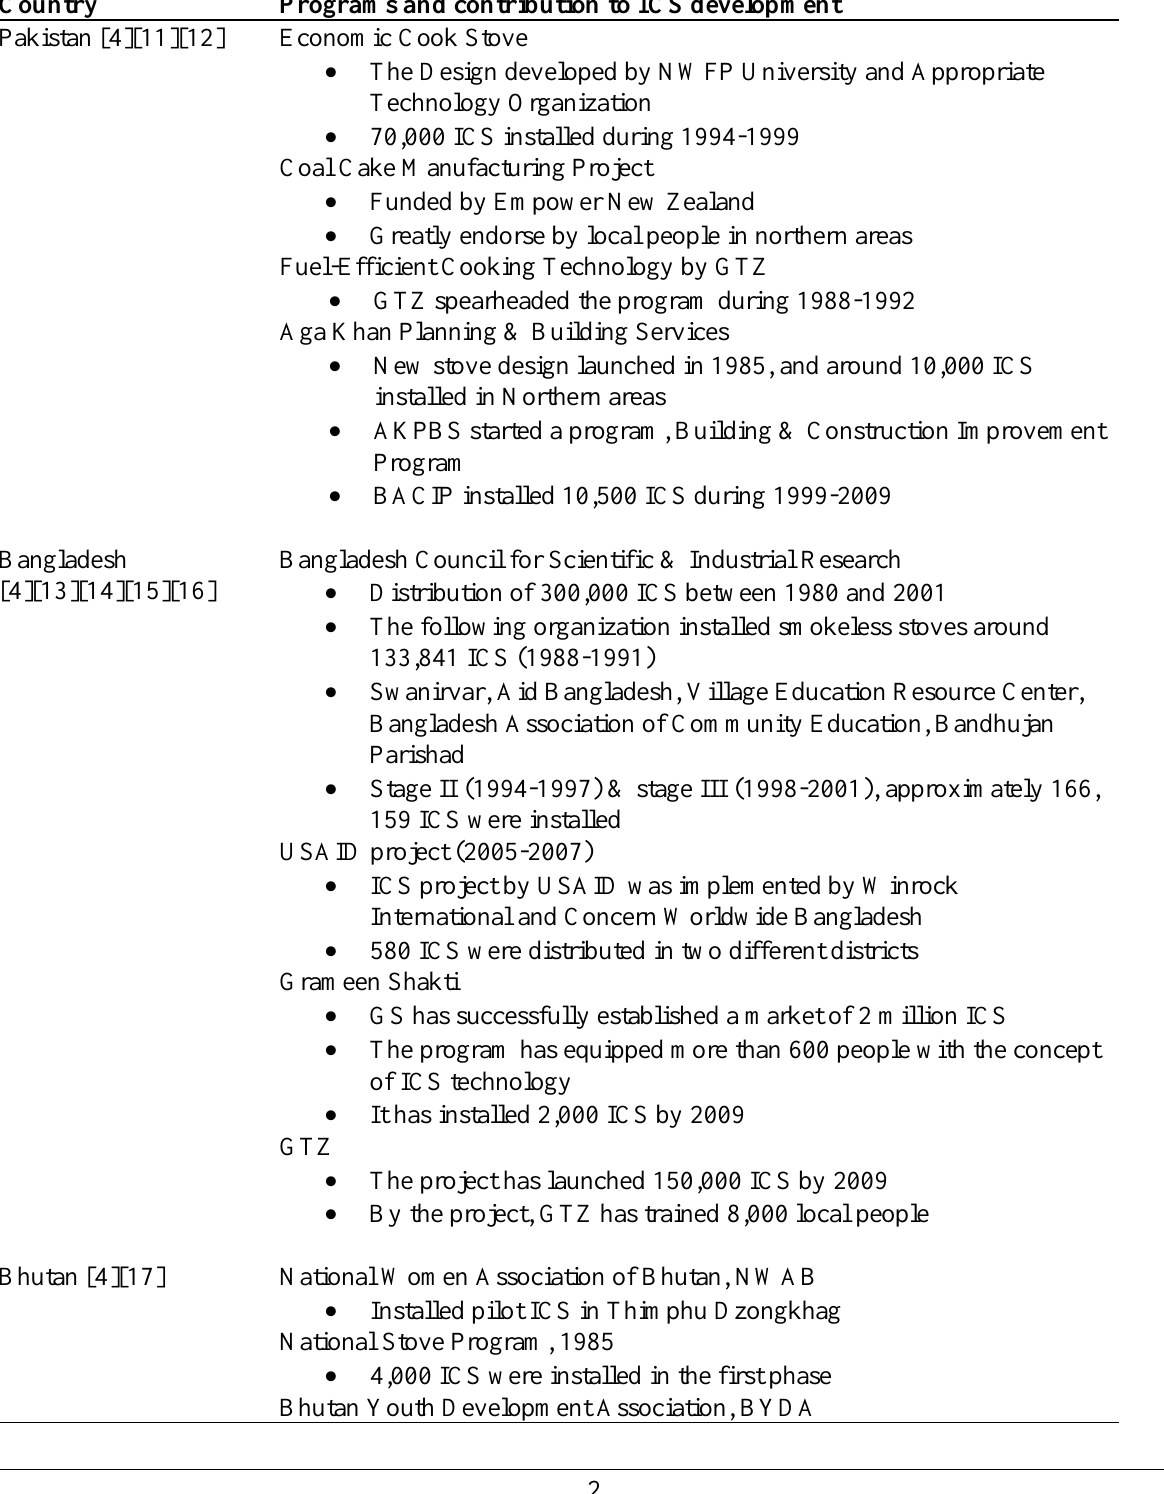
Table 1. Improved cooking stove program in various